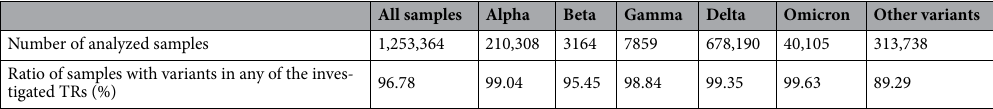
Table 2. Total number of SARS-CoV-2 samples analyzed, and ratio of samples affected by a genomic variation in at least one investigated TR.